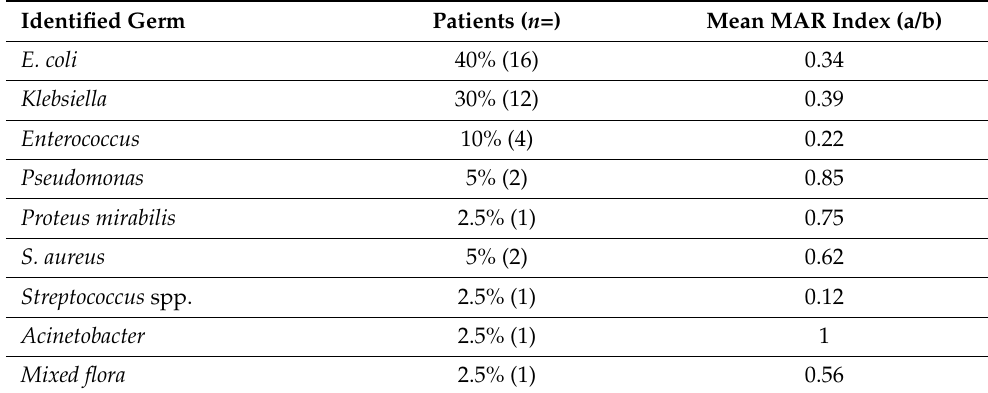
Table 2. Incidence of identified germs and the mean MAR